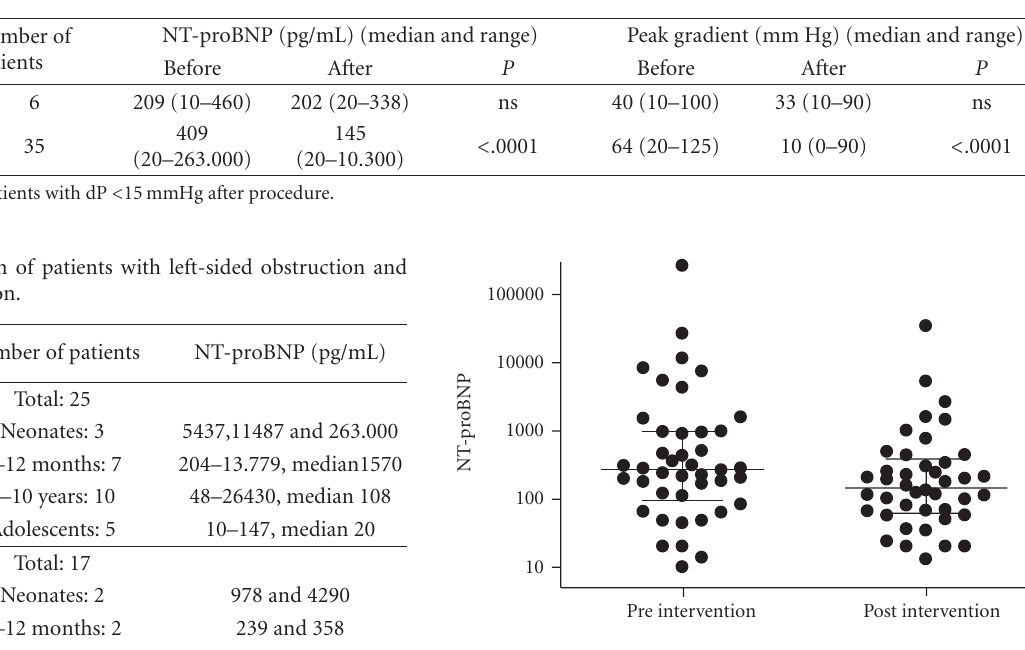
Figure 1: The evolution of the actual NT-proBNP values (log 10, pg/mL) before and after intervention to treat a cardiac stenosis. The di ff erence between the values before and after intervention was highly statistically significant using Wilcoxon’s matched pairs test ( P < .